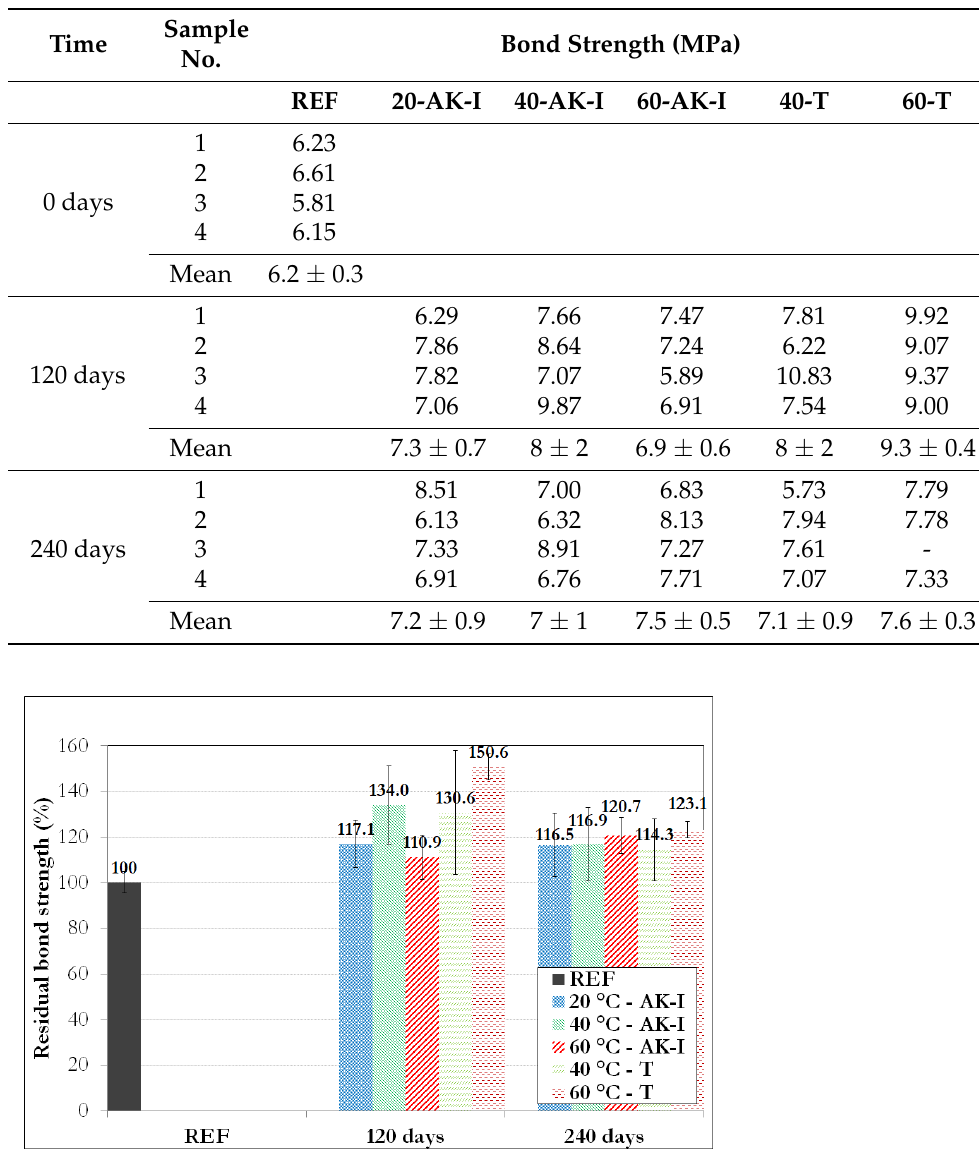
Table 10. Results of pull-out tests performed on reference and aged specimens.